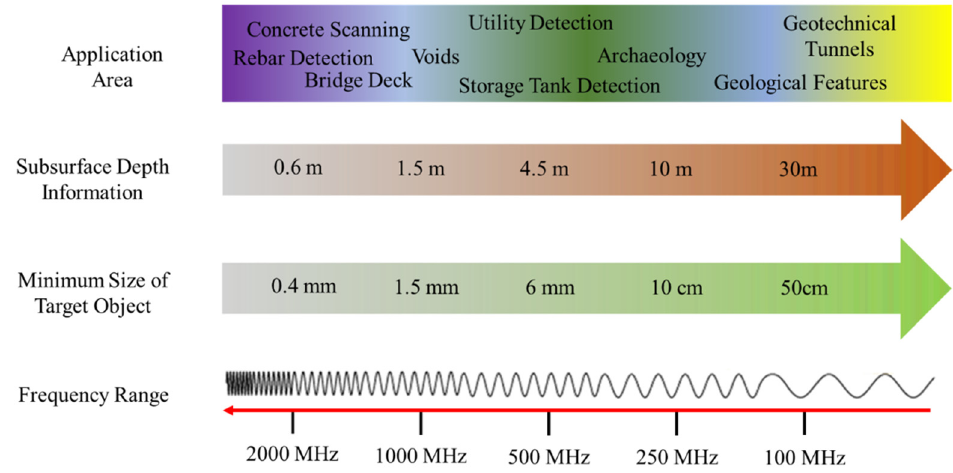
Figure 3. The typical range of frequencies for the application of GPR [36].